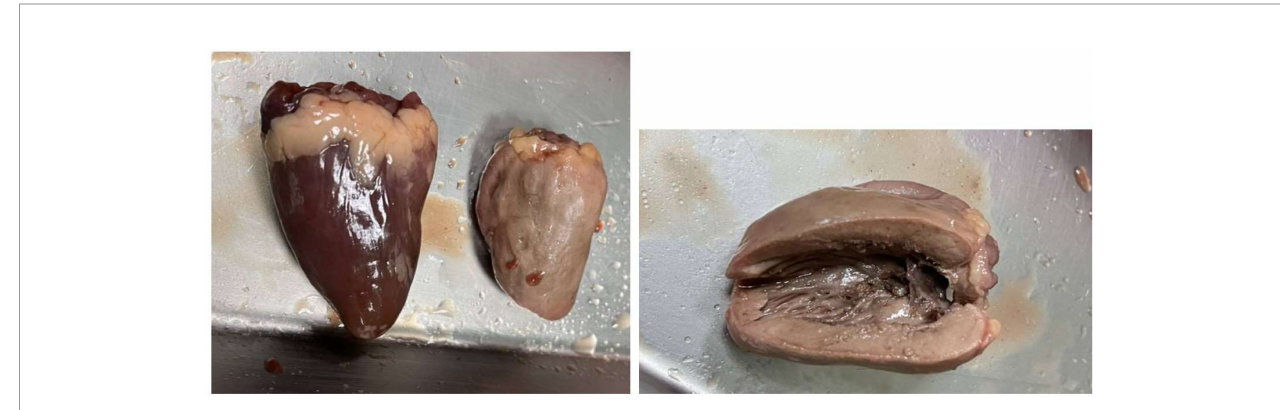
FIGURE 3 | The successful ablations were de fi ned as the color of chicken hearts from bright red to off-white, indicating that the meat was fully cooked.